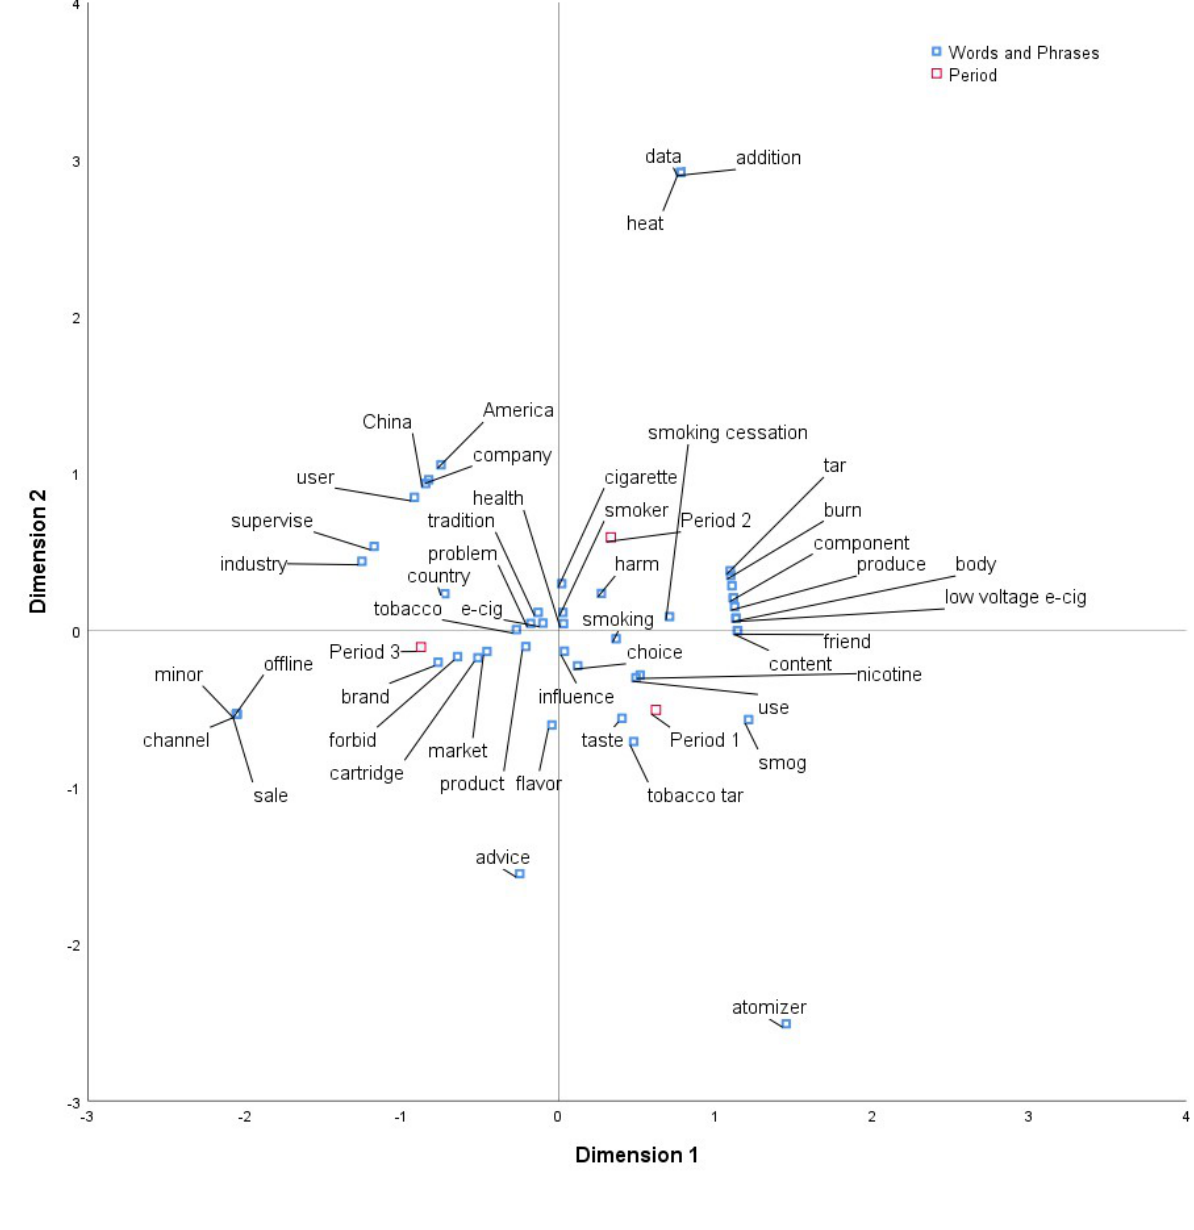
Figure 1. Correspondence map for frequently used words and phrases represented in different